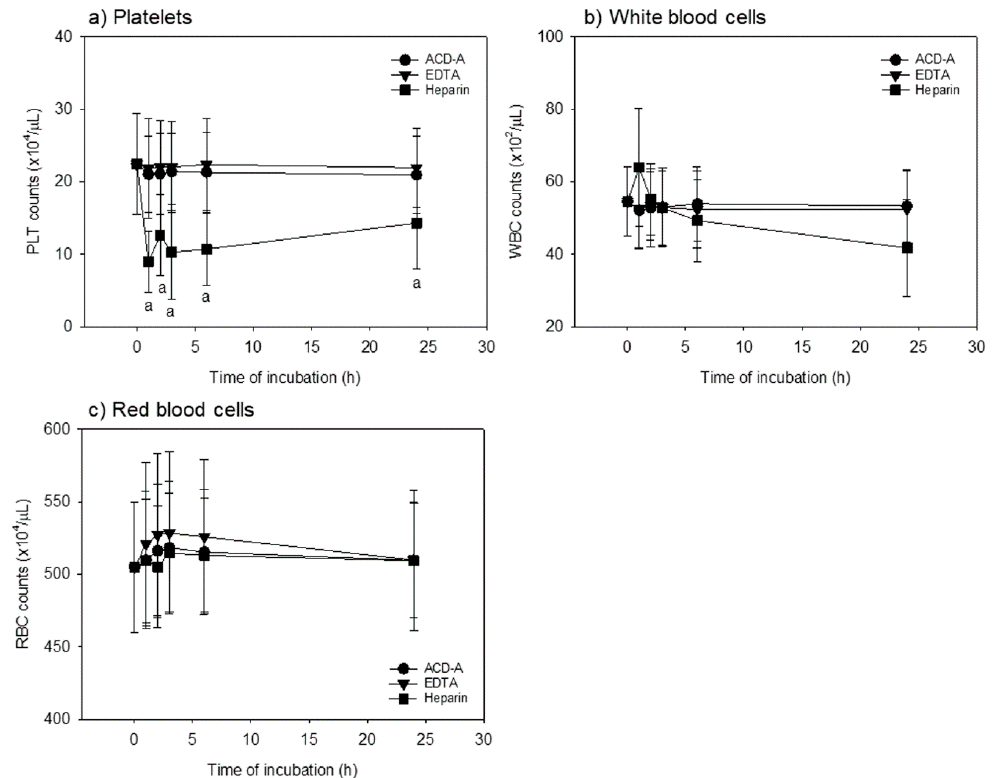
Figure 1. Time-course e ff ects of anticoagulants on platelet and white and red blood cell counts in whole-blood samples. Whole-blood samples were stored following mild mixing at room temperature for up to 24 h. ( a ) Platelet counts: heparin-anticoagulation treatments significantly ( p < 0.05, vs. A-form of acid-citrate-dextrose (ACD-A) and EDTA) reduced platelet counts (vs. other anticoagulation treatments) at the same time points from 1 to 24 h. ( b ) White blood cell counts: heparin-anticoagulation treatments significantly reduced white blood cell counts only at 24 h (vs. ACD-A-anticoagulation treatments). ( c ) Red blood cell counts: no significant di ff erences were observed among the groups. n =